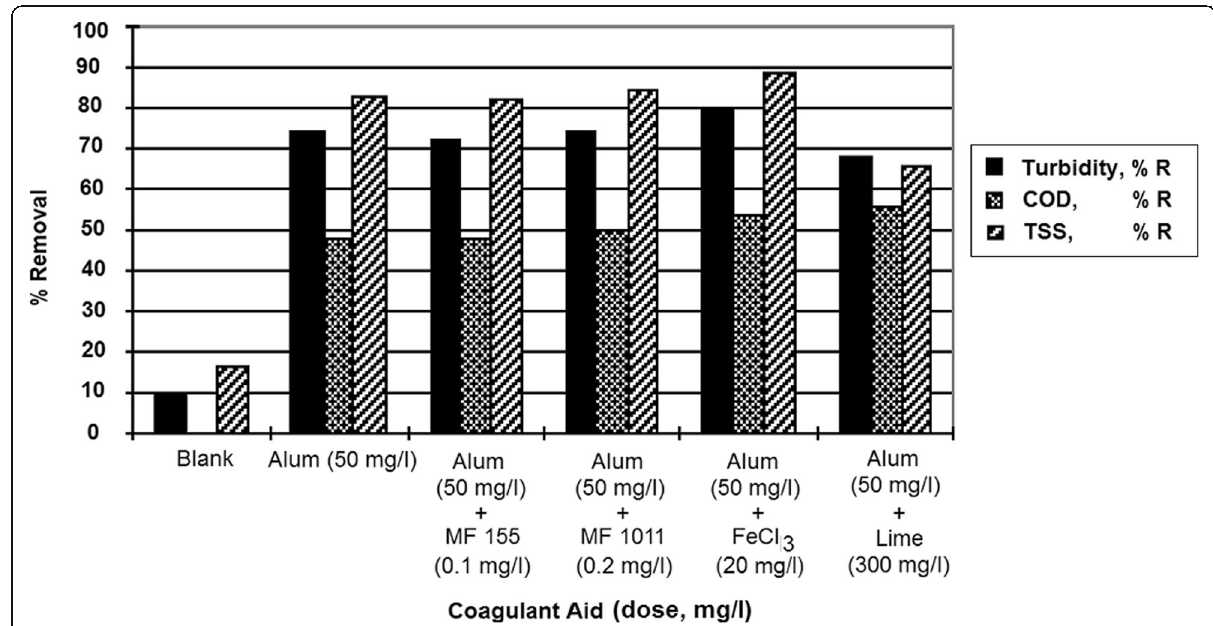
Fig. 1 Comparison between the use of alum alone and in combination with coagulant aids and other